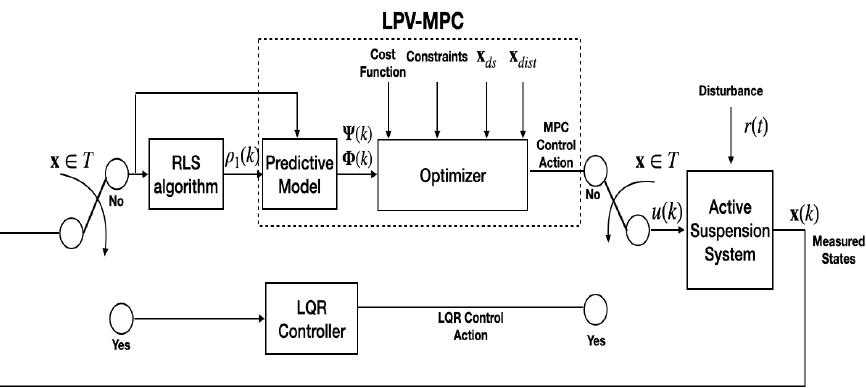
Figure 3. Block diagram of the proposed LPV-MPC-LQR control strategy for the Active Suspension system.